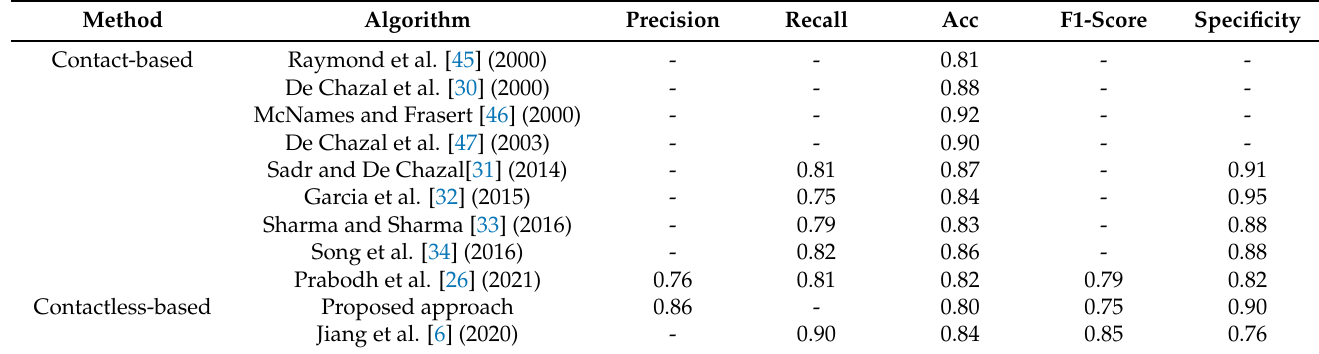
Table 4. Comparison of existing research results with the proposed method.